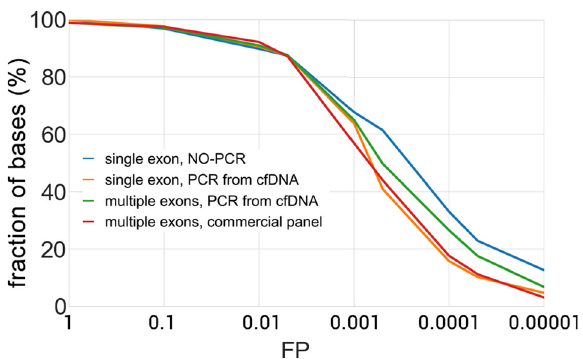
Fig. 4 False positive rate for COSMIC mutations in TP53 . False positive (FP) rate was obtained for four representative runs: two runs based on a single TP53 exon, one run covering multiple TP53 exons, and one run covering all TP53 exons. For each COSMIC position in the target insert, the FP was calculated. The y-axis represents the percentage of bases having a snFP value lower than the